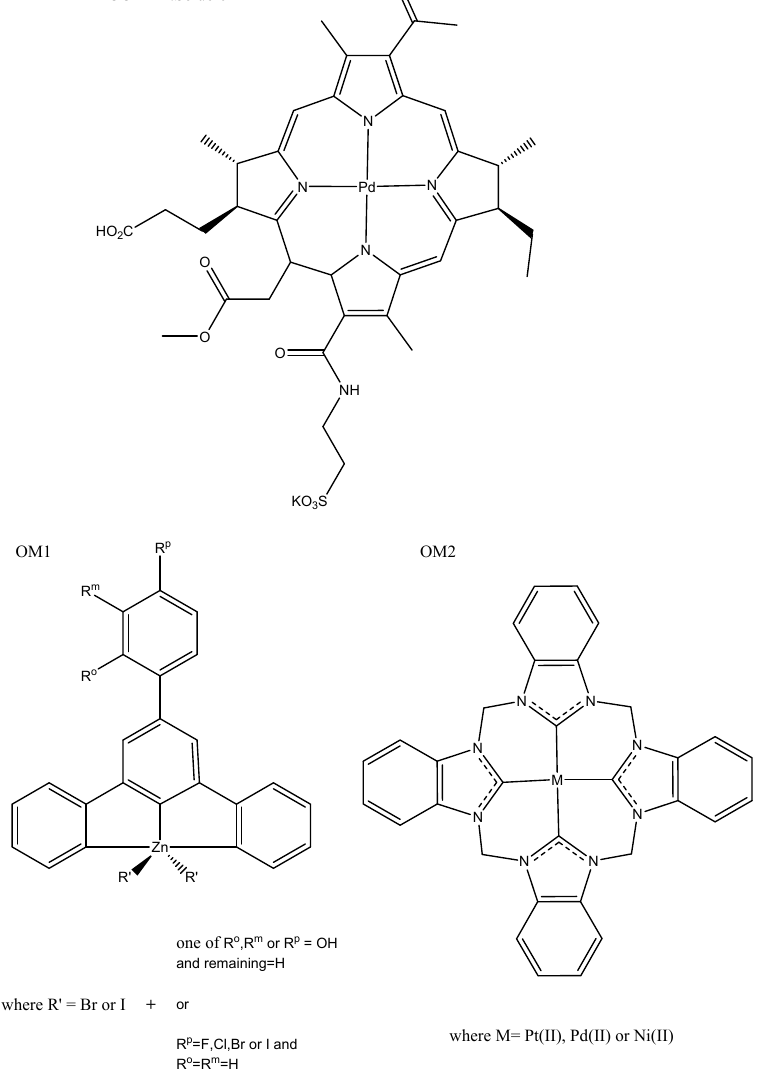
Figure 14. Examples of other transition metal fluorescent anticancer complexes [84,108,112,113].